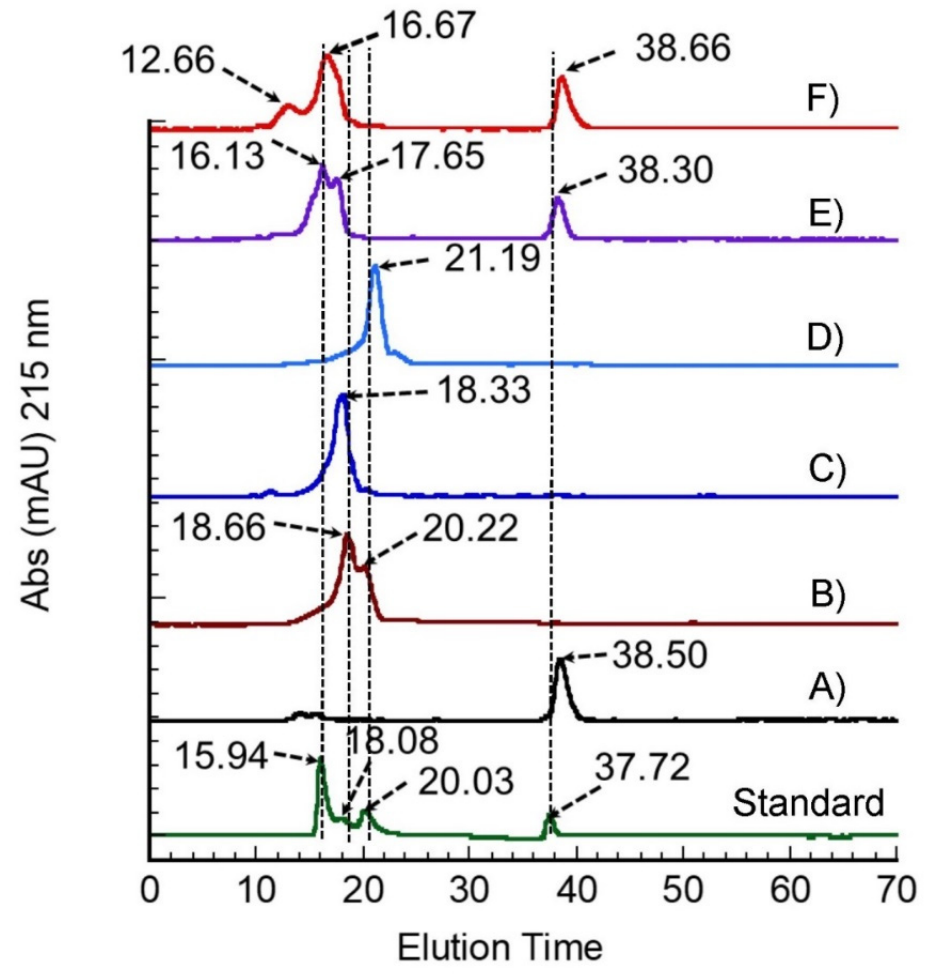
Figure 3. Fast performance liquid chromatography of SS extracts; ( A ) Pure Glycine, ( B ) water, ( C ) EtOH 5%, ( D ) EtOH 10 %, ( E ) Glycine 5 %, ( F ) Glycine 10 % and MW Standard. Table 2. Molecular weight distribution in FPLC.